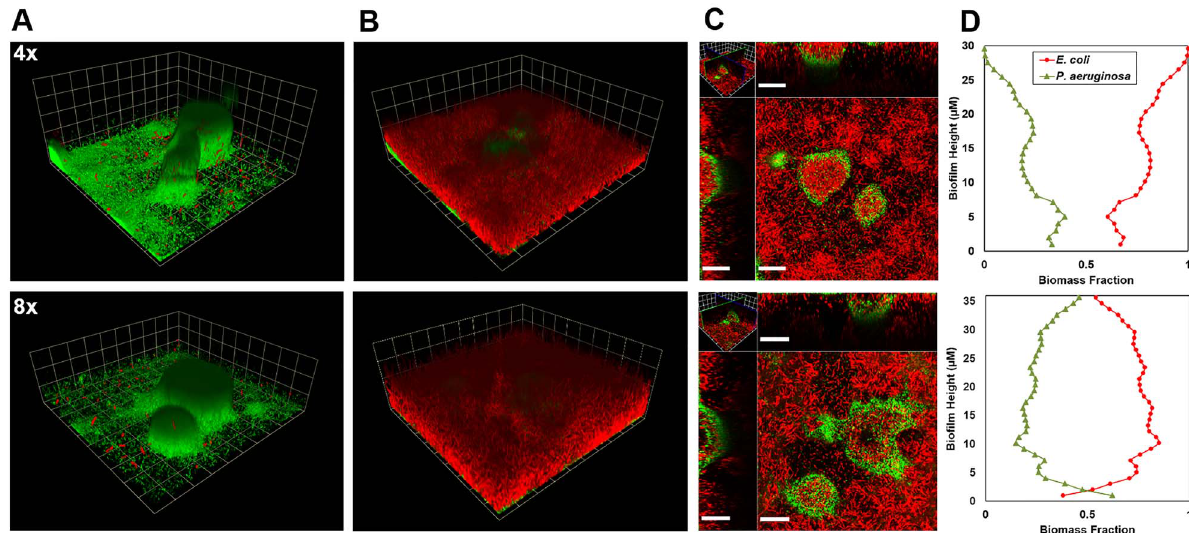
Figure 3. Colonization of P.aeruginosa biofilms by E.coli under varying R2A medium concentrations in a microfluidic flow cell. E. coli appears red and P. aeruginosa appears green. Column A) E. coli deposited on 3-day old mono-species P. aeruginosa biofilms under 4x and 8x R2A concentrations (grid unit is 23.8 m m). B) P. aerugiosa and E. coli biofilms on day 6, 3 days after introduction of E. coli (grid unit is 23.8 m m). C) Horizontal section near the base of the biofilm and vertical sections of the biofilm shown in panel B (scale bar=40 m m). D) Biomass fraction vs.